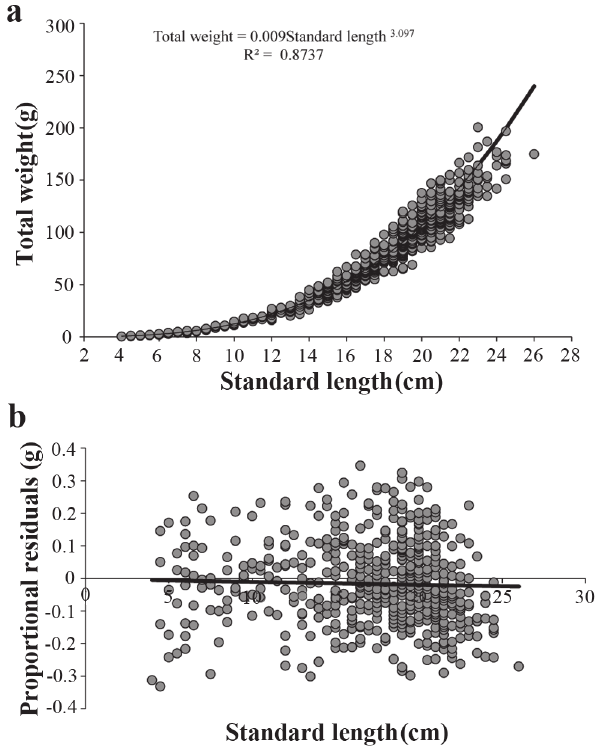
Fig. 4. Weight-length relationship ( a ) and the distribution of the proportional residuals ( b ) in Anableps anableps females collected at the mouth of the Maracanã River, Pará State.